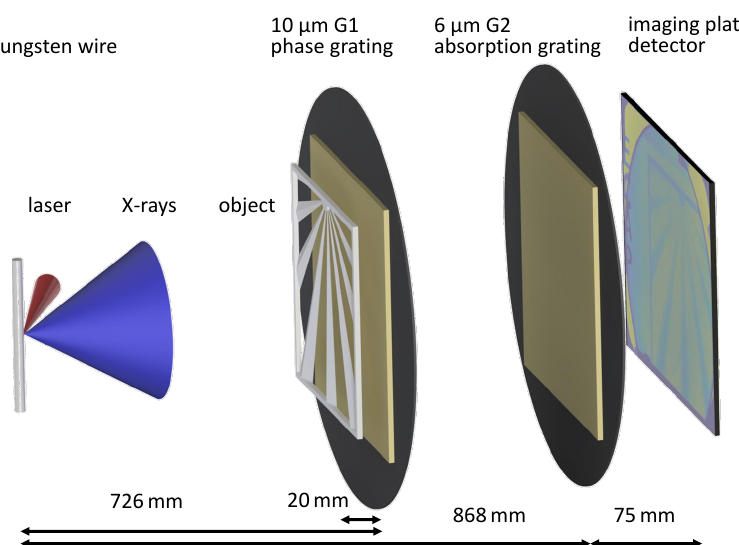
Figure 3. 3D rendering of the imaging setup (not to scale). The 5 µ m-thick tungsten backlighter wire, that serves as a broadband X-ray source, is driven by a 700fs infrared laser pulse from the PHELIX high-power laser system. Both gratings are mounted on the portable (yet rigid) setup at distances of 726mm and 868mm from the source. The object is placed at approximately 20mm in front of G1. The detector is mounted 75mm behind the G2 grating. The setup is designed to yield a Moiré fringe period of 350 µ m in the detector plane, with a visibility of the Moiré pattern of up to 16%. The presented dataset consists of six images—one image with a sample and five without. Hence, five different reference images are available for one object